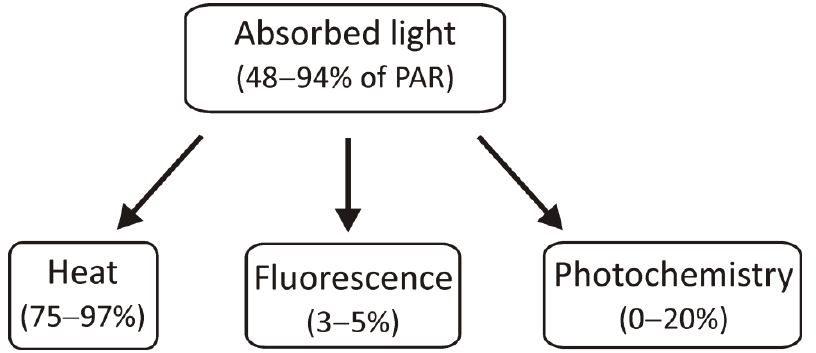
Figure 2. The scheme presents the use of absorbed light energy for photochemical reactions, heat dissipation, and radiation by fluorescence. PAR: photosynthetically active radiation.